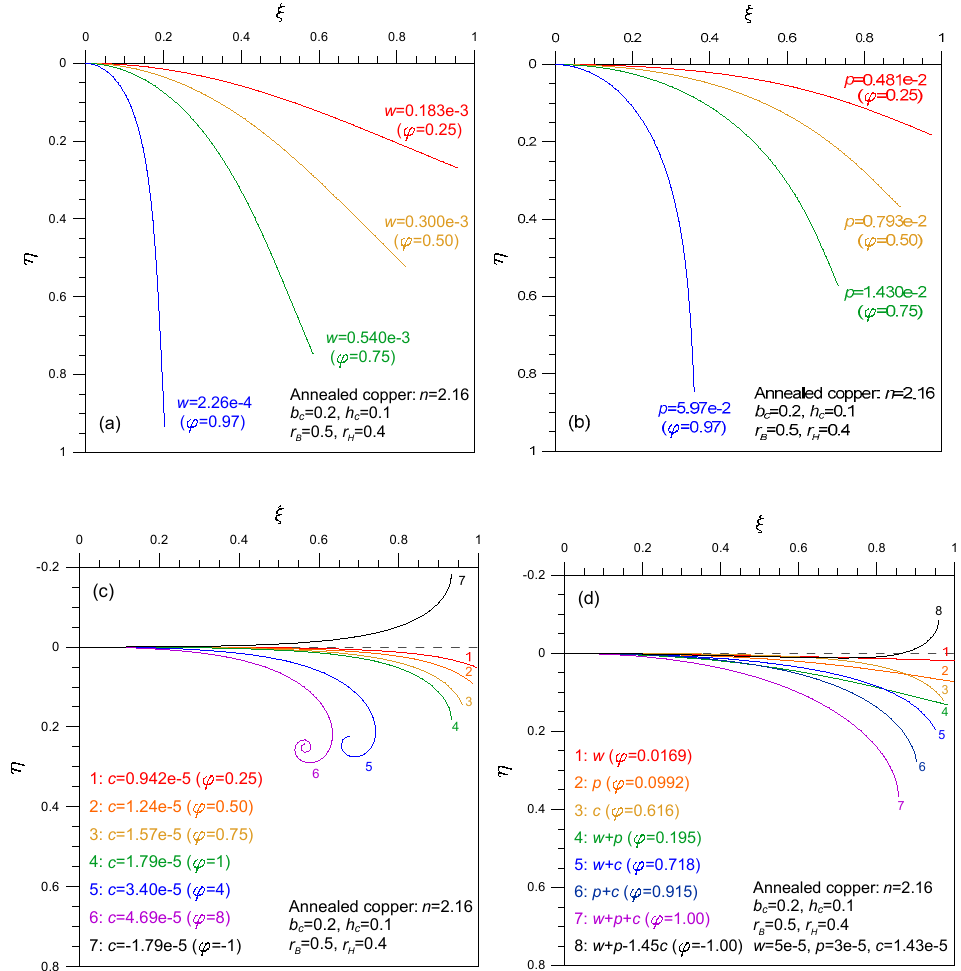
Figure 5. Elastica of beams subjected to ( a ) uniform loading, ( b ) tip point loading, ( c ) tip couple loading, and ( d ) combined loading.